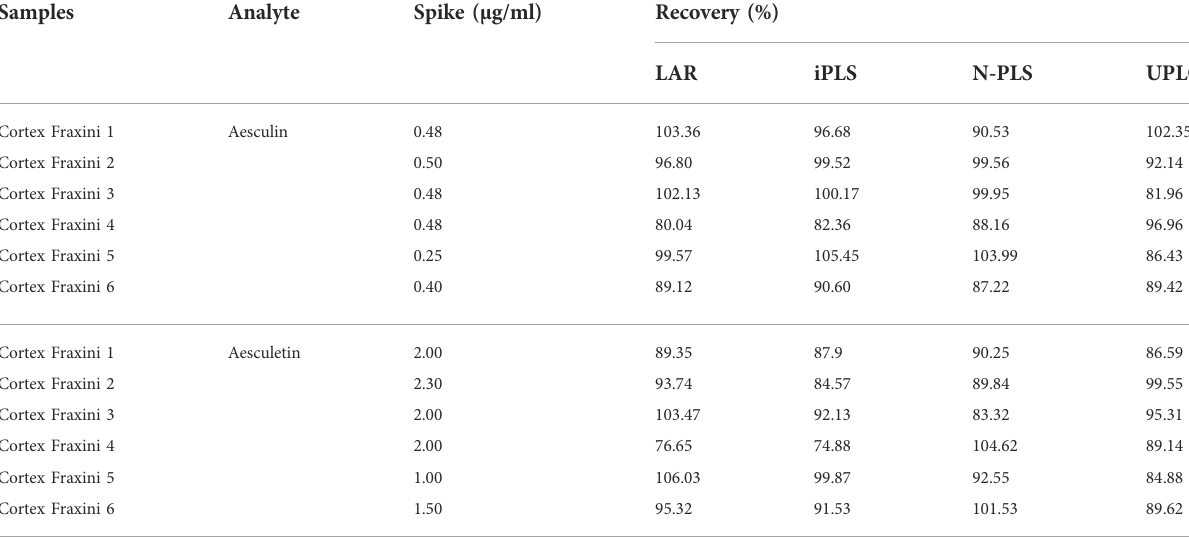
TABLE 2 Recovery values obtained by different methods.